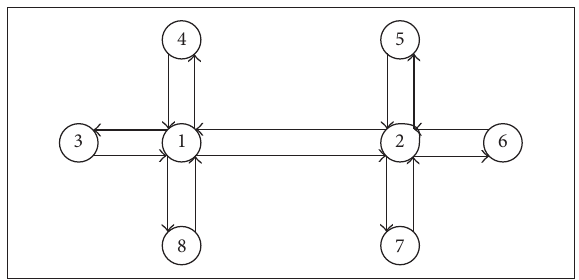
Figure 3: Two-intersection